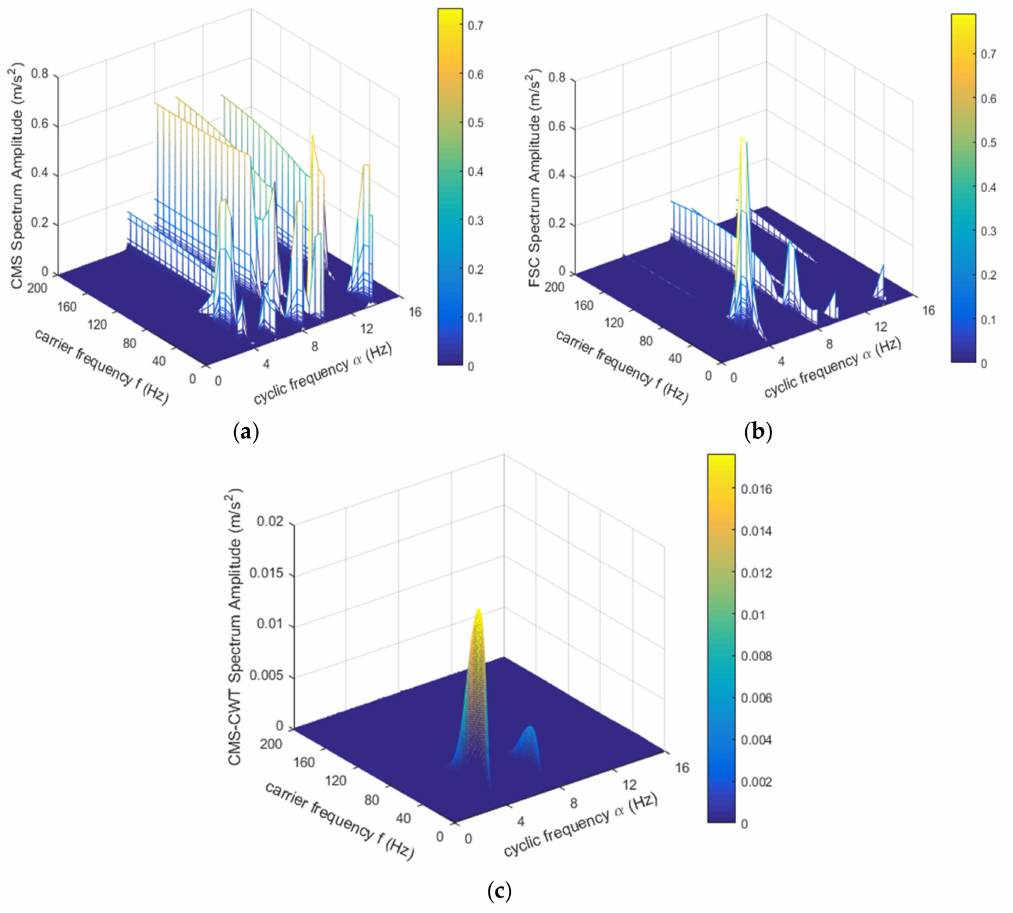
Figure 6. Three-dimensional vibration spectrum analysed by ( a ) CMS, ( b ) FSC, and ( c ) CMS-CWT with Fs = 1000